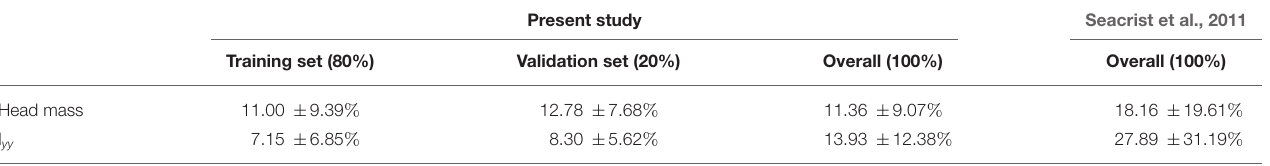
TABLE 3 | Mean errors and standard deviations obtained in the estimation of the head inertial properties.